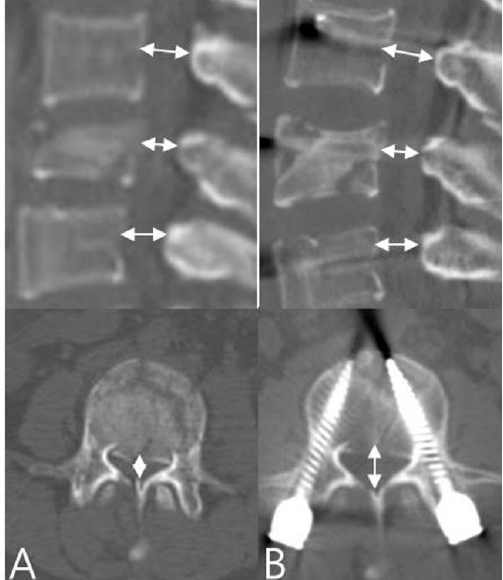
Figure 2. Spinal canal encroachment and clearance were calculated ( A ) before and ( B ) after sur gery on CT scans. The percentage of canal compromise was calculated with the narrowest mid-sagittal diameter of the injured level divided by the mean of the mid-sagittal diameters of the adjacent upper and lower vertebrae.